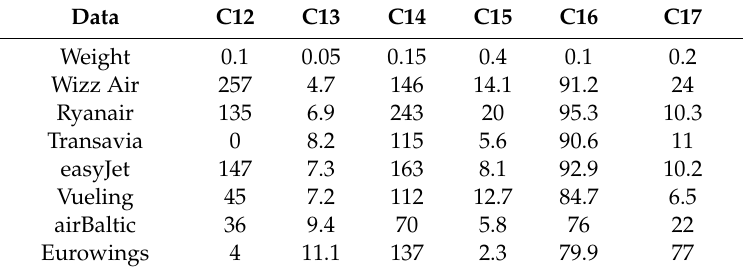
Table A6. Full calculations of the successfulness TOPSIS.